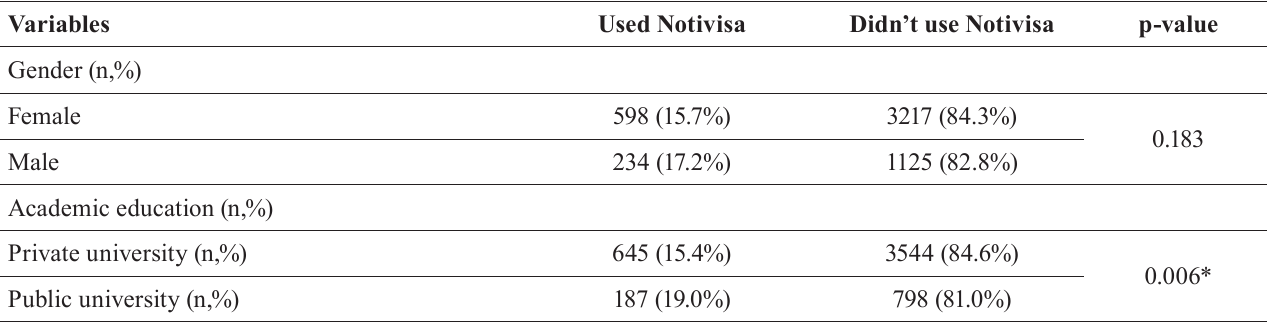
TABLE IV - Association between use of Notivisa and sociodemographic variables